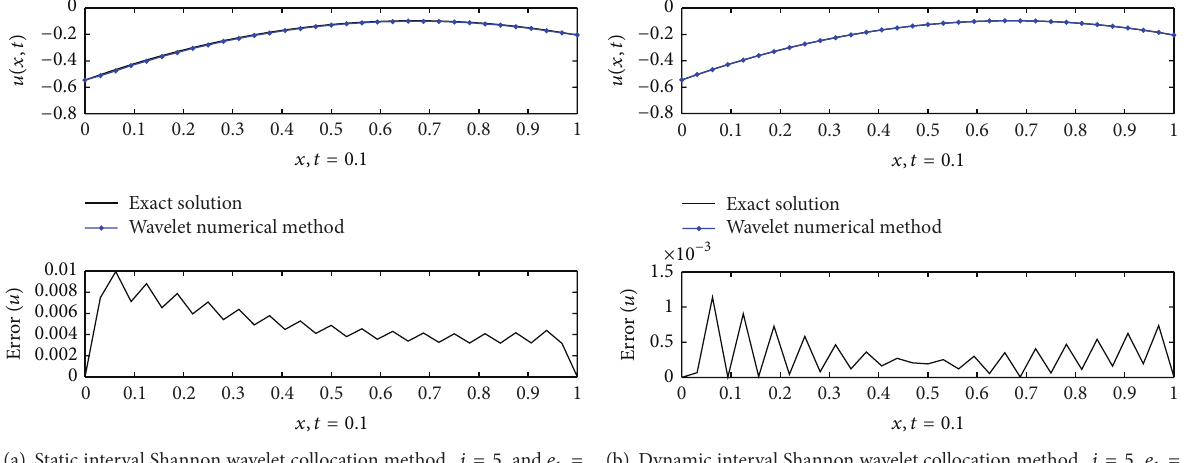
Figure 4: Finite-difference method ( 𝛼 = 0.8 ).